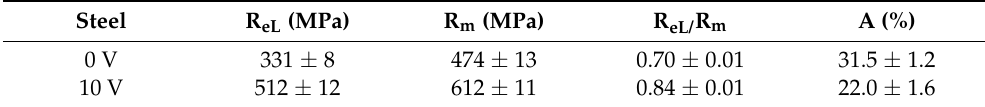
Table 4. Mechanical property of the tested steels.